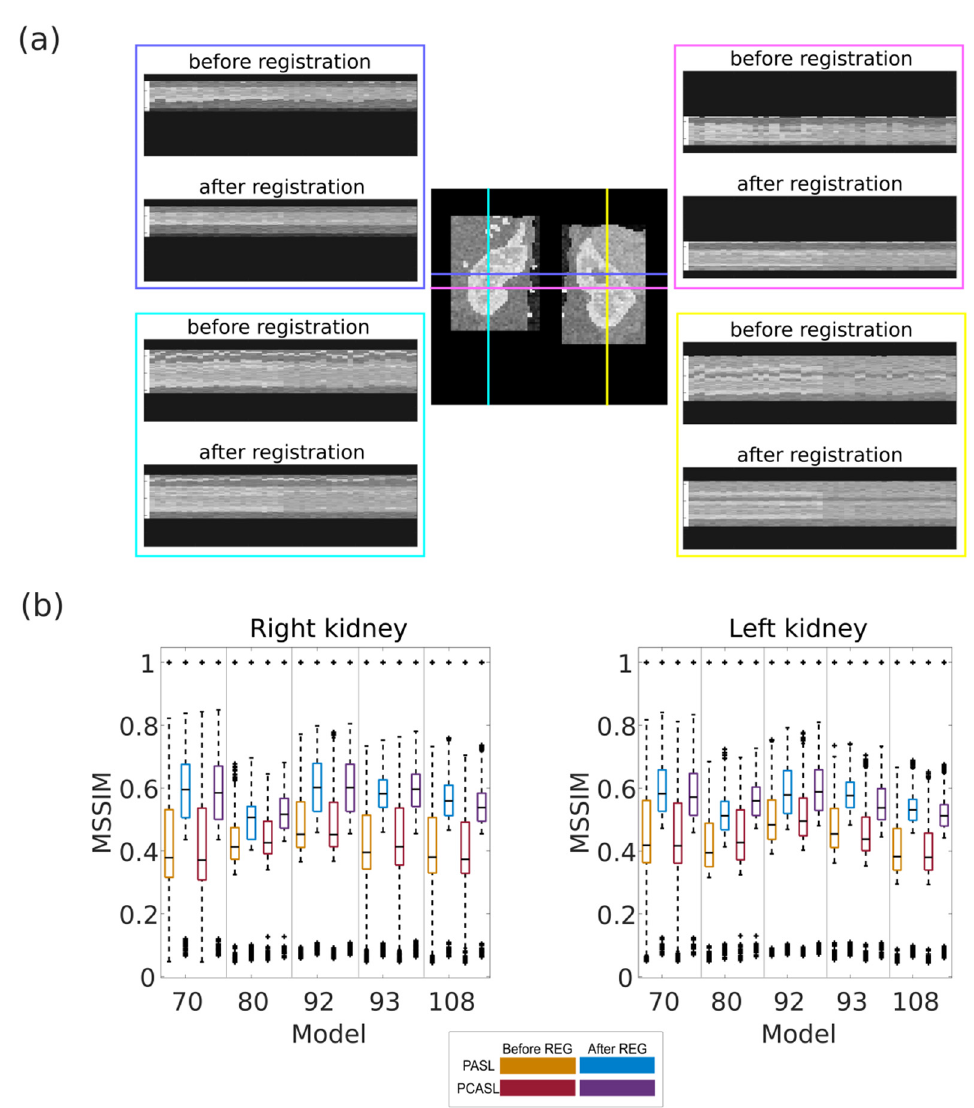
Figure 2. ( a ) Line profiles across all ASL images before and after registration (model 93, PASL). ( b ) MSSIMs calculated before and after registration for all possible image pairs within each healthy data set. The black line in each boxplot shows the median of the distribution of mean perfusion across all models. The top and bottom part of each boxplot represent the 25th and 75th percentiles. The box- plots’ whiskers extend to the highest and lowest data points not considered as outliers. Outliers are shown a black ‘+’.